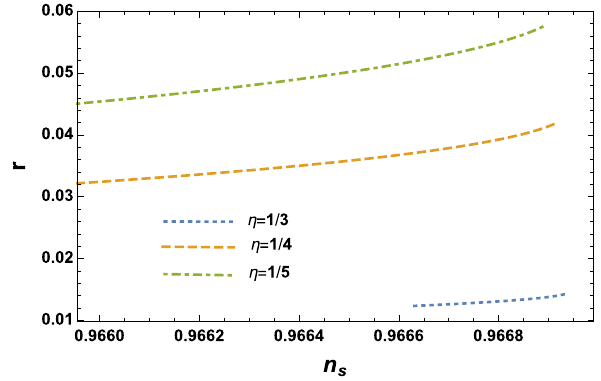
Fig. 3 n s vs r for β in the interval 10 7 ≤ β ≤ 10 8 for N = 60 and η = 1 / 3 , 1 / 4 , 1 / 5. Note that n s basically does not change along this interval while r is significantly more susceptible to changes in η . For all curves f = 0 . 001